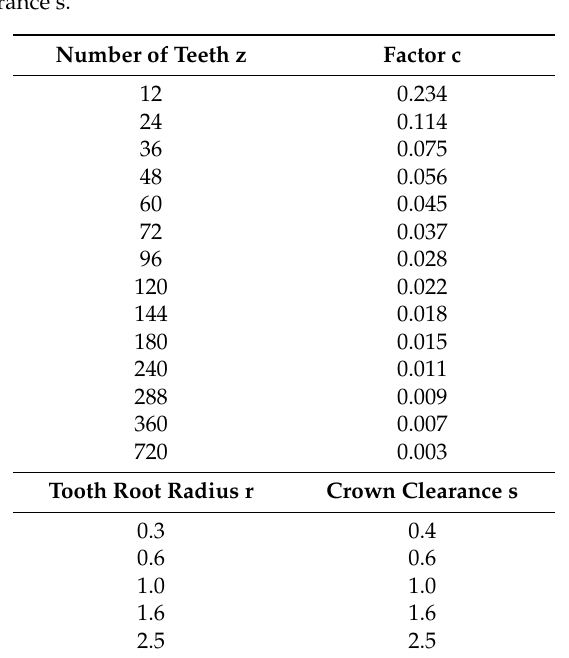
Figure 4. Geometric parameters from the manufacturer “Voith-Turbo Gmbh”. Table 2. Tables provided by the manufacturer “Voith-Turbo Gmbh” for the proper choice of Factor c and of the crown clearance